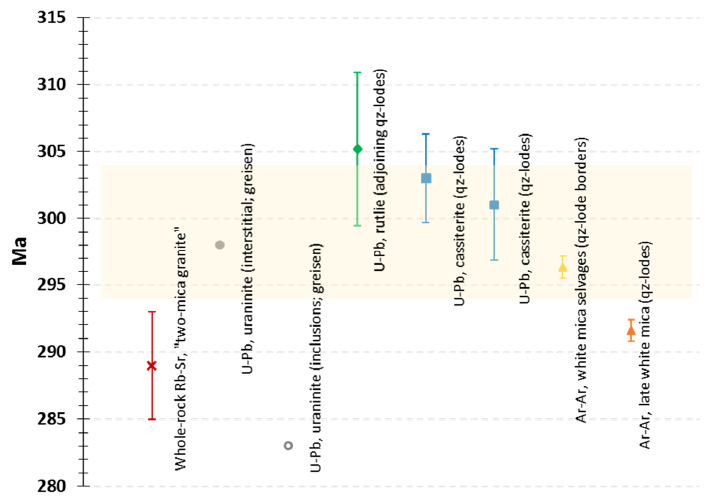
Figure 13. Graphic representation of the ages determined so far for the Panasqueira system, allowing the inference of 299 ± 5 Ma for the multiple fluid influxes related to the onset of ore-forming processes in the Panasqueira system. The (short-lived?) rejuvenation event should have occurred at ca. 292 Ma.